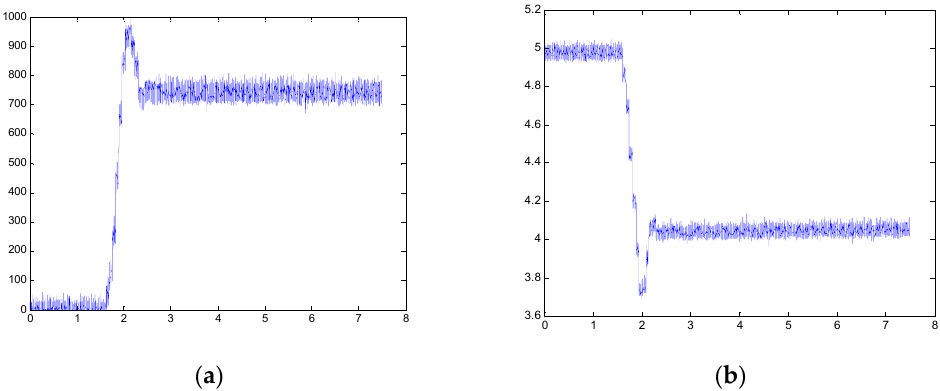
Figure 6. Configuration of the traditional sliding mode control. ( a ) The traditional SMC; ( b ) the proposed SMC.